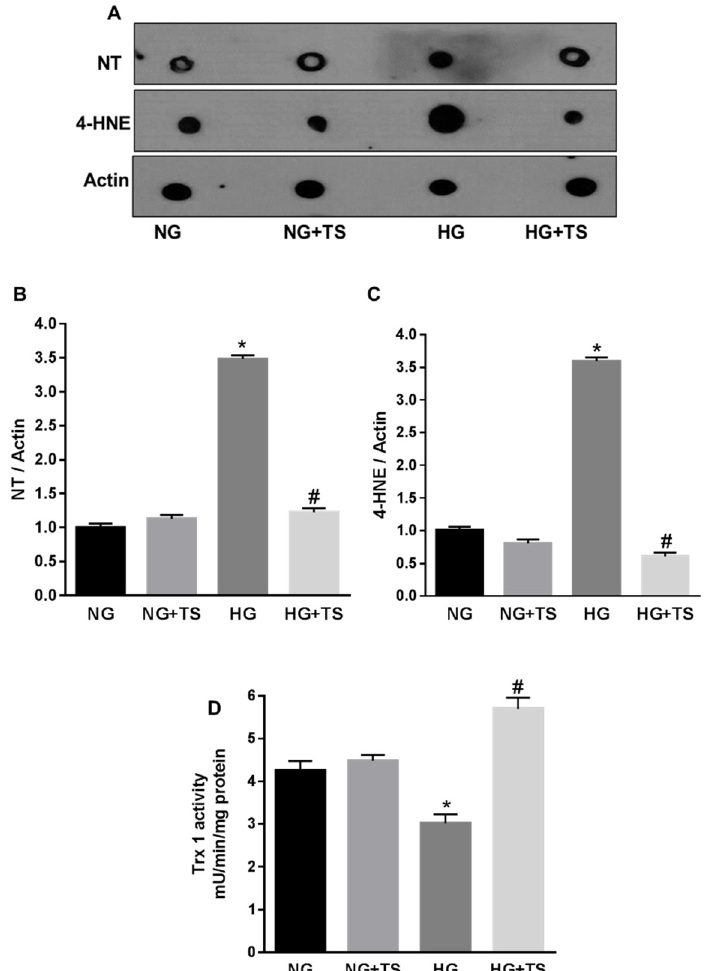
Figure 9. Effects of Tubastatin A on high glucose ‐ induced redox imbalance in HuREC. ( A ) Representative images of dot blot analysis demonstrating nitrotyrosine (NT) and 4 ‐ hydroxynonenal (4 ‐ HNE) formation in HuREC exposed to HG for 48 h or HG in the presence of 5 μ M of TS (HG + TS), also for 48 h, and compared to HuREC cultured in NG conditions in the absence (NG) or presence of 5 μ M TS (NG + TS). ( B – C ) Quantification of optical density of NT and 4 ‐ HNE immunoblotting normalized versus actin. Values are mean ± SEM for n = 3. * p < 0.0001 vs. NG and # p < 0.0001 vs. HG. ( D ) Fluorimetric assay results representing Trx ‐ 1 activity in HuREC assessed after 48 h of exposure to different glucose levels (NG = 5.5 mM D ‐ glucose, HG = 25 mM D ‐ glucose) in the presence or absence of TS (5 μ M). Values are mean ± SEM for n = 3. * p < 0.01 vs. NG and # p < 0.01 vs. HG.